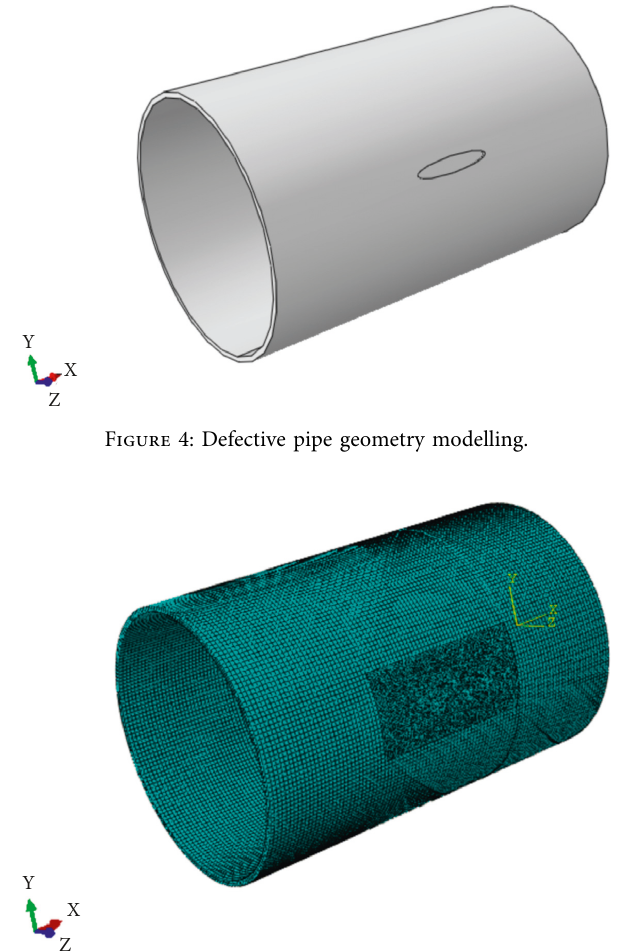
Figure 5: Defective pipe mesh modelling.